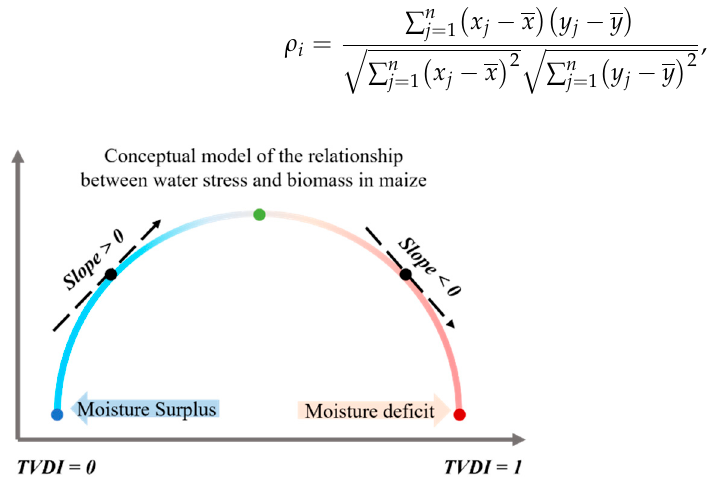
Figure 3. The conceptual model of the effect of water stress on maize biomass, adapted from Wan et al. [49].